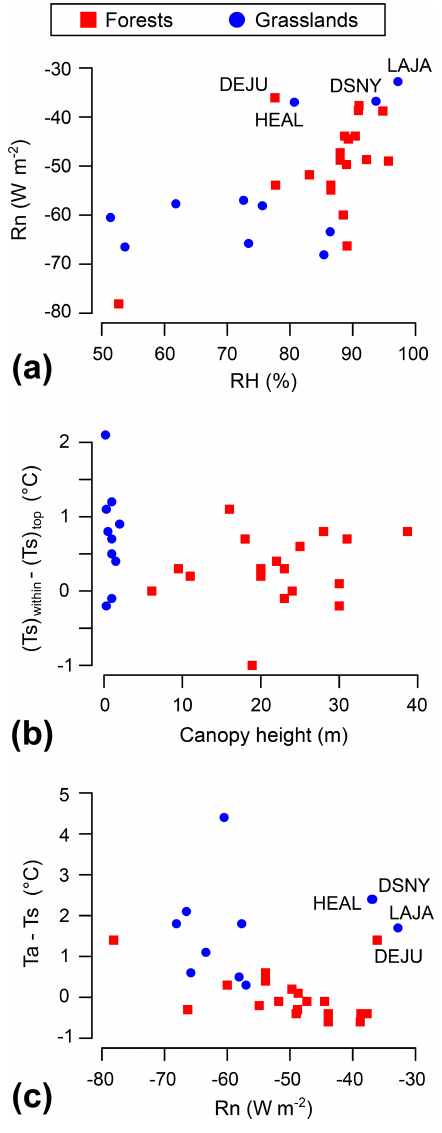
Figure 3. Mean values from 23:00 to 05:00 the next day for each site over the growing season for the following parameters: R n versus RH (a) , difference in T s between the canopy within and the top of the canopy versus the canopy height (b) , and T a − T s (within canopy for the forests, top of the canopy for the grasslands) versus R n (c) . Four sites are selected for